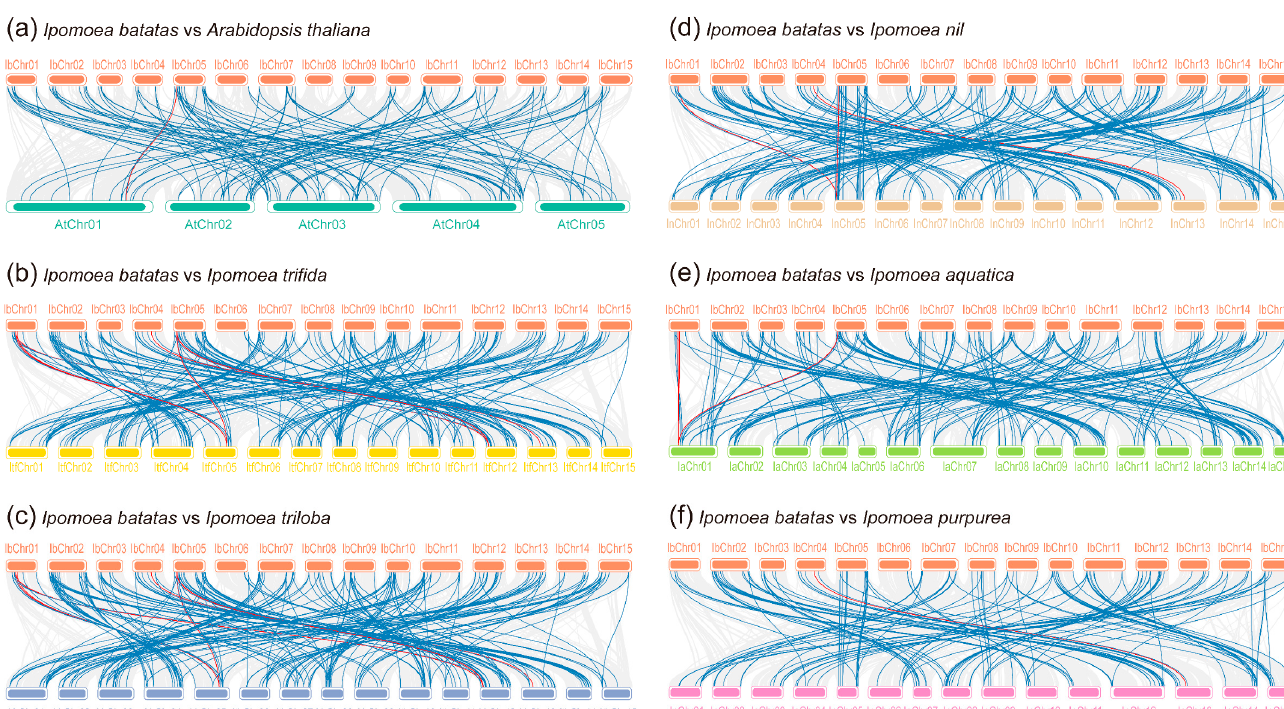
Figure 4. Interspecies collinear analysis of R2R3-MYBs between I. batatas and Arabidopsis, and other five Ipomoea species. ( a ) Collinear analysis of IbR2R3-MYBs between AtR2R3-MYBs . ( b ) Collinear analysis of IbR2R3-MYBs between ItfR2R3-MYBs . ( c ) Collinear analysis of IbR2R3-MYBs between ItbR2R3-MYBs . ( d ) Collinear analysis of IbR2R3-MYBs between InR2R3-MYBs . ( e ) Collinear analysis of IbR2R3-MYBs between IaR2R3-MYBs . ( f ) Collinear analysis of IbR2R3-MYBs between IpR2R3- MYBs . The gray line links show the collinear block with I.batatas and six other plant species’ genomes. The blue lines show collinear gene pairs related to R2R3-MYBs , while the red lines show collinear gene pairs related to R2R3-MYBs belonging to clade C24(S6). The detailed information is listed in Table S5.